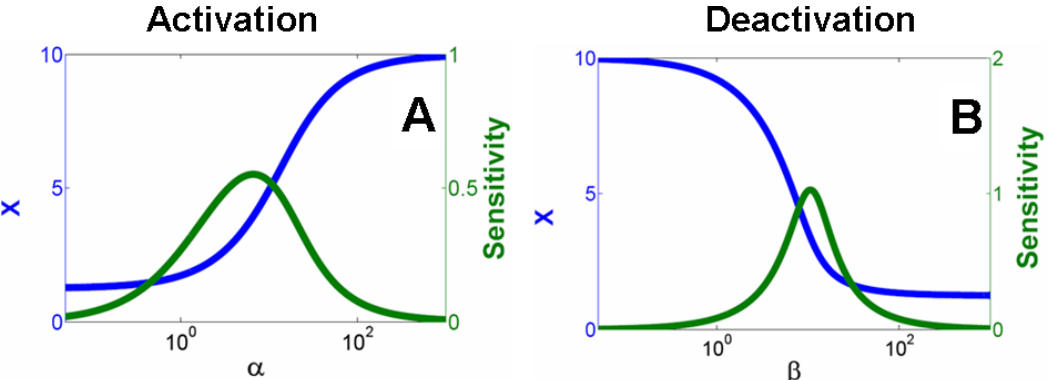
Figure 4. System sensitivity to input signal perturbations. (A) At a given synthesis rate constant ( k =10), the maximal activated level of X at the steady-state (X